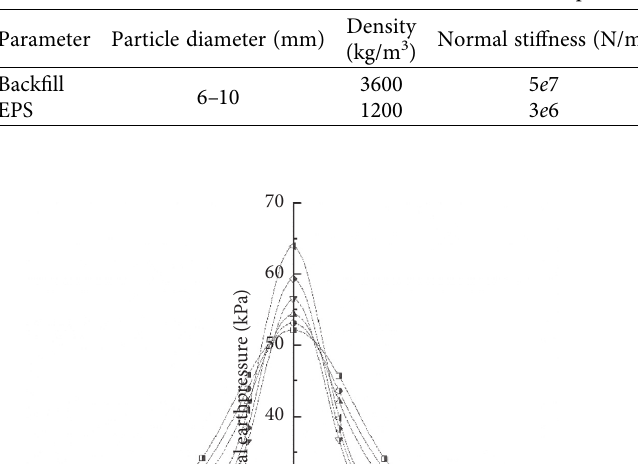
Table 2: Micromechanical parameters of the numerical model.